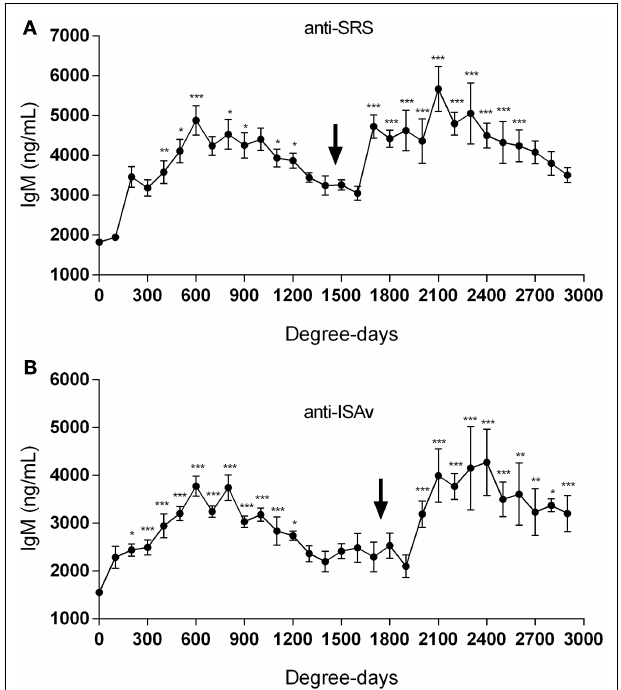
FIGURE 3 | Oral immunizations increase antibody production . Fish were immunized by injectable vaccines as primo-vaccination and later as booster immunization by the oral route against SRS (A) and ISAv (B) infections. The IgM level was followed up to 3000degree-days. The arrow indicates the time-point where the oral vaccine was administrated. Samples were statistically analyzed by one-way ANOVA – Dunnet post-test. (SRS 120 fish/point, ISAv 65 fish/per point) * p < 0.05; ** p < 0.01; *** p < 0.001.